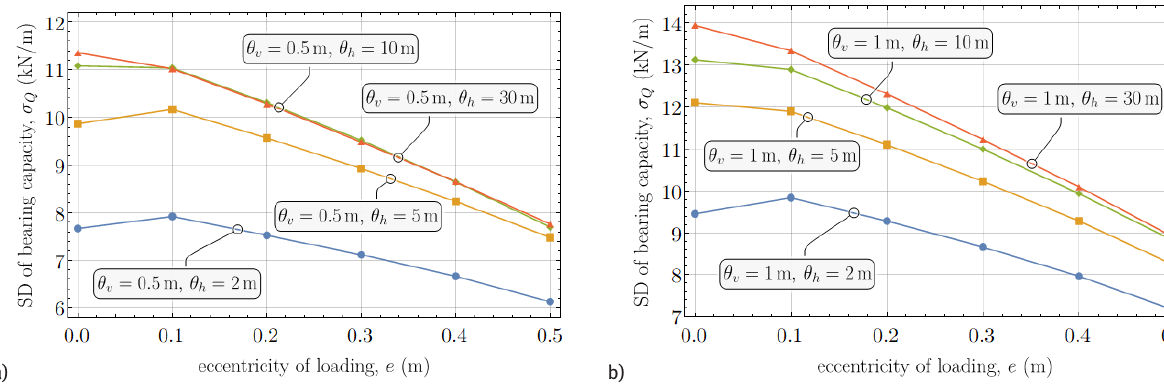
for a) θ = 0.5 m and b) θ Q v